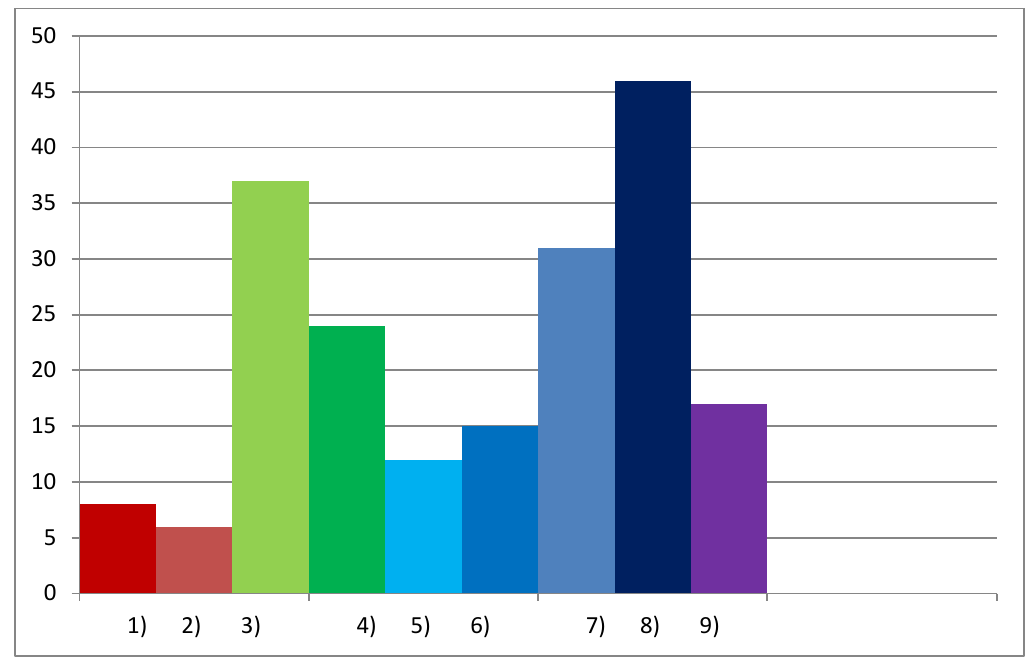
Figure 1. Example of a figure